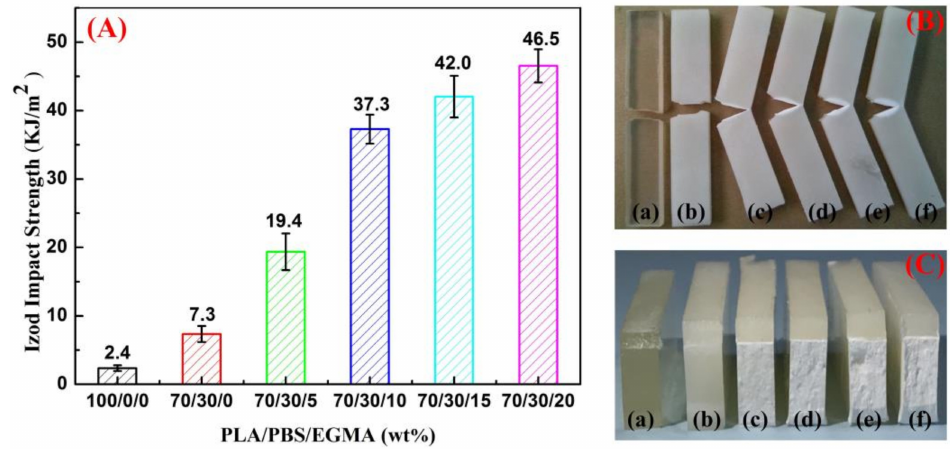
The impact properties of neat PLA, PLA/PBS and PLA/PBS/EGMA blends: ( A ) impact strength; ( B – C ) deformed impact samples: ( a ) neat PLA; ( b ) PLA/PBS 70/30; ( c – f ) PLA/PBS/EGMA (70/30/x): ( c ) 5 wt %; ( d ) 10 wt %; ( e ) 15 wt %; ( f ) 20 wt